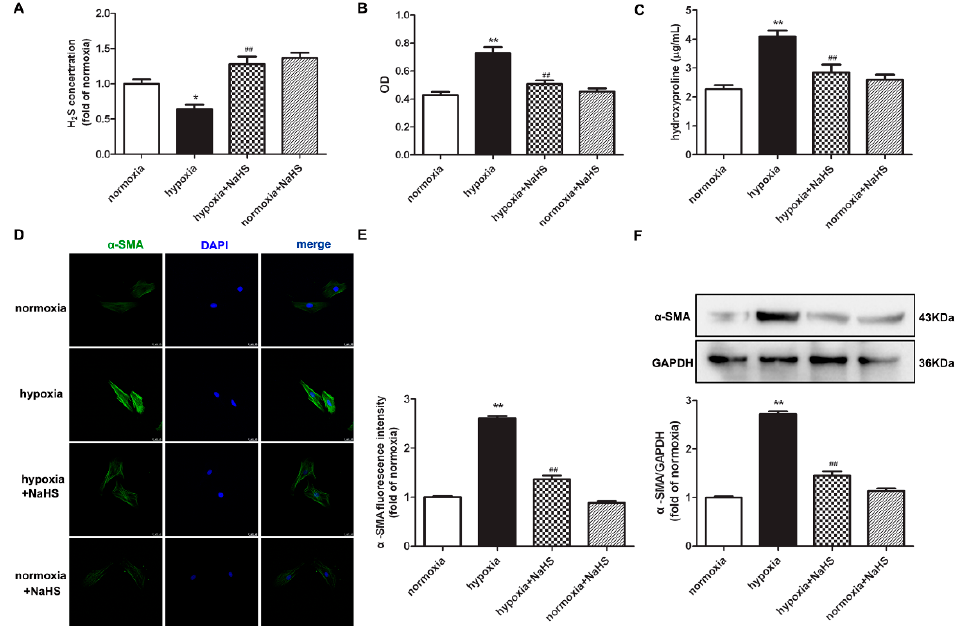
Figure 1. NaHS decreased the cell number, hydroxyproline content, and α -SMA expression in cardiac fibroblasts with hypoxia. After pre-administration with NaHS (50 µ M) for 4 h, neonatal rat cardiac fibroblasts were subjected to normoxia (containing 5% CO 2 and 95% O 2 ) or hypoxia (containing 5% CO 2 and 1% O 2 ) for 4 h. ( A ) The H 2 S concentration in the culture medium was measured with an H 2 S-specific microelectrode. ( B ) The cardiac fibroblast number was measured with the CCK-8 kit. ( C ) Hydroxyproline content in the cell culture medium was detected. ( D ) α -SMA was immunofluorescence stained with Alexa Fluor 488 (green)-conjugated IgG. The nuclei were stained with DAPI (blue). Bar = 25 µ m. ( E ) The fluorescence intensity of α -SMA was quantified using ImageJ software. ( F ) Expression of α -SMA protein was detected by Western blot. * p < 0.05, ** p < 0.01 vs. normoxia; ## p < 0.01 vs. hypoxia, n = 6.